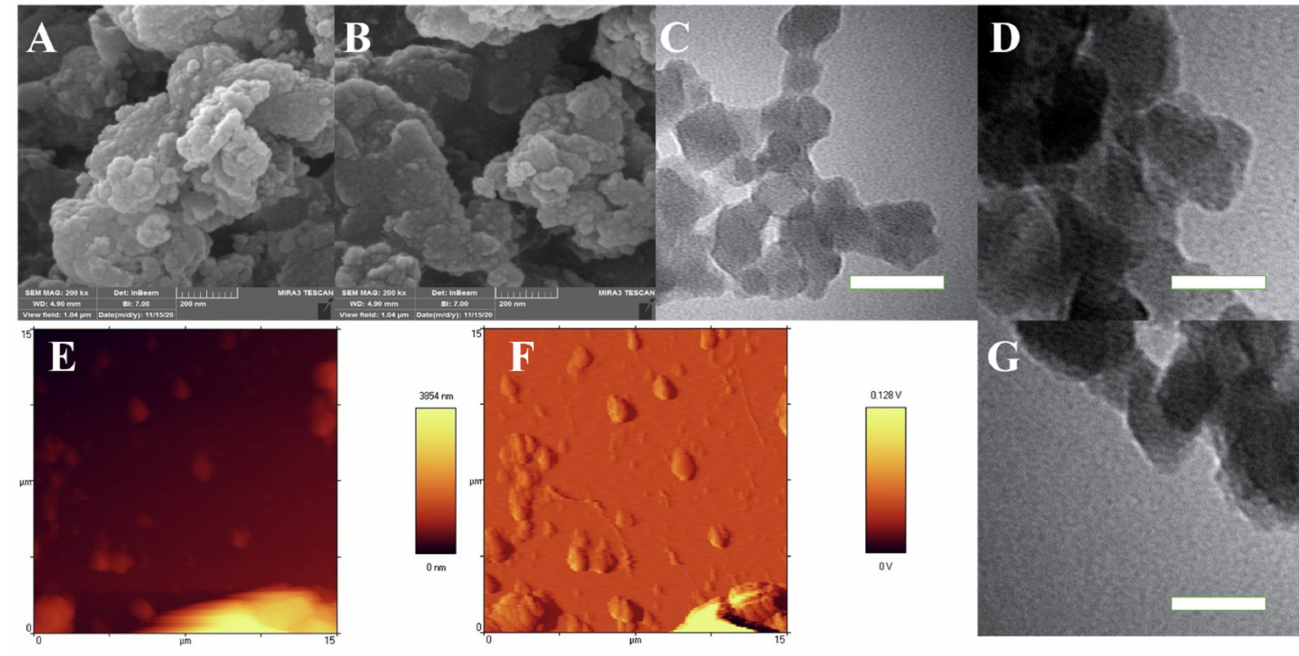
Figure 2. FESEM ( A , B ) (from different places to prove the homogeneity of the nanostructure), TEM ( C , D , G ) (from different places to prove the homogeneity of the nanostructure), and 2D AFM ( E , F ) (from different places to prove the homogeneity of the nanostructure) results of the NH2-MIL-53@H2TMP. Scale bar of the TEM images is 80